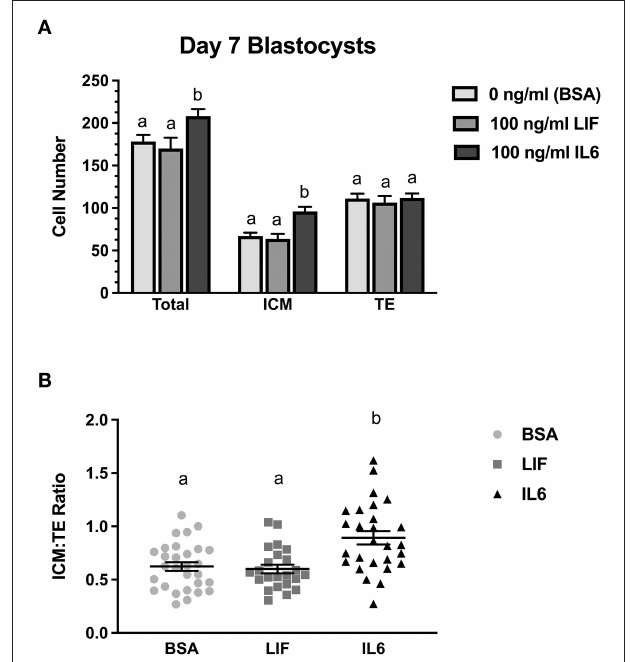
FIGURE 2 | Comparison of LIF vs. IL6 supplementation on day 7 blastocyst cell numbers ( n = 23–29 blastocyst/treatment/timepoint over 3 replicates). (A) Effects of 100ng/ml IL6 or 100ng/ml LIF on total, inner cell mass (ICM), and trophectoderm (TE) cell numbers in day 7 blastocysts. (B) Effects of 100ng/ml IL6 or 100ng/ml LIF on ICM:TE ratios of day 7 blastocysts. Different superscripts within each panel indicate differences ( P <